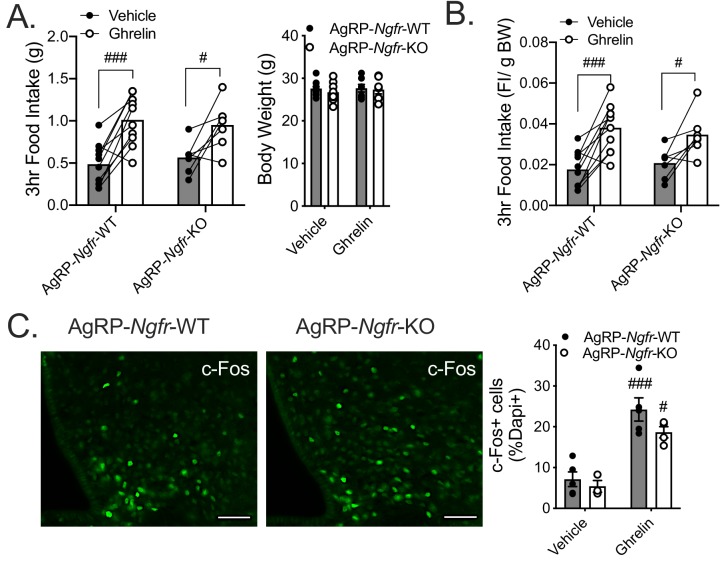
Ghrelin-induced feeding is intact in AgRP-Ngfr-KO mice.(A) Three hour food intake following central infusion of either vehicle or ghrelin (1 ug) in ad libitum fed AgRP-Ngfr-KO mice or controls (left). Mice are weighed prior to infusion (right). n = 10 WT, 7KO. ###p=0.0003, #p=0.0162, versus vehicle. F(1,15)=30.5 by two-way repeated measures ANOVA with Bonferroni multiple comparisons. Comparison between genotypes is not significant by two-way repeated measures ANOVA with Bonferroni multiple comparisons. (B) Food intake normalized to total body weight. ###p=0.0003, #p=0.022, versus vehicle. F(1,15)=30.02 by two-way repeated measures ANOVA with Bonferroni multiple comparisons. Comparison between genotypes is not significant by two-way repeated measures ANOVA with Bonferroni multiple comparisons. (C) Immunofluorescent staining for c-Fos (left) approximately 90 min after central infusion of ghrelin. Scale bar = 50 µM. Quantification (right) as the percent of c-Fos+ cells/dapi+ cells in each treated AgRP-Ngfr-KO or control mouse; n = 3–5/group. ###p=0.003, #p=0.0117, versus vehicle. F(1,13)=46.59 by two-way repeated measures ANOVA with Bonferroni multiple comparisons. Comparison between genotypes is not significant by two-way repeated measures ANOVA with Bonferroni multiple comparisons. Data are presented as mean ± SEM.